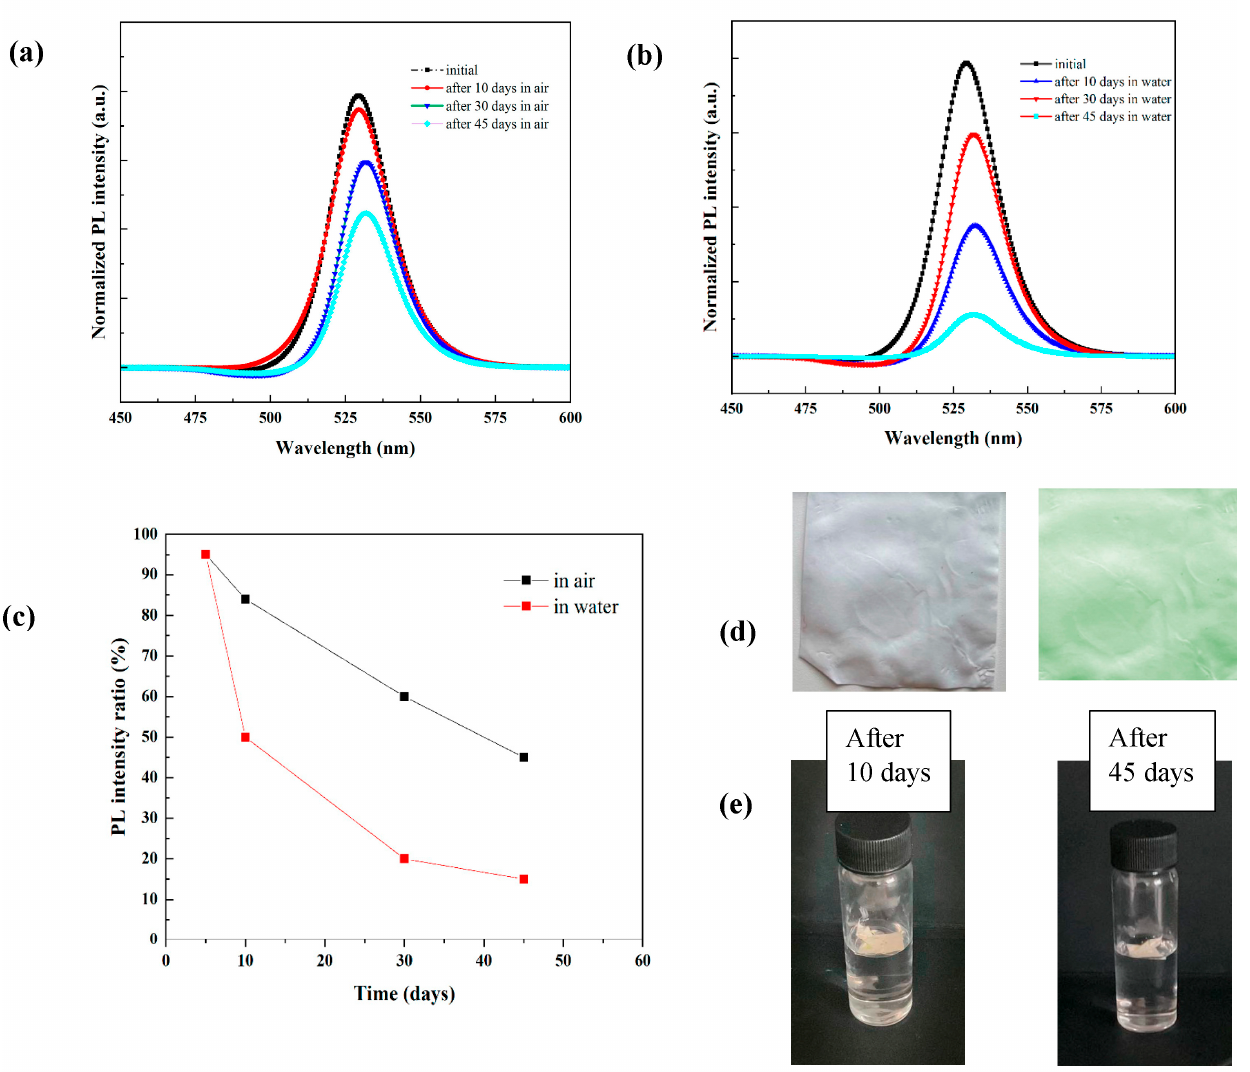
Figure 7. PL intensity variation spectra of FAPbBr 3 NCs–PLLA nanofibres with storage time ( a ) in air and ( b ) in water. ( c ) Summary of PL intensity ratio for the composite films as a function of storage time in air and water. ( d ) Photographs of PLLA nanofibres and FAPbBr 3 NCs–PLLA nanofibres. ( e ) Photographs of FAPbBr 3 NCs–PLLA nanofibres after immersion in water after 10 and 45 days. Table 1. Comparison of the FAPbBr 3 perovskite NCs incorporated in poly (L–lactic acid) nanofibers with some other materials.